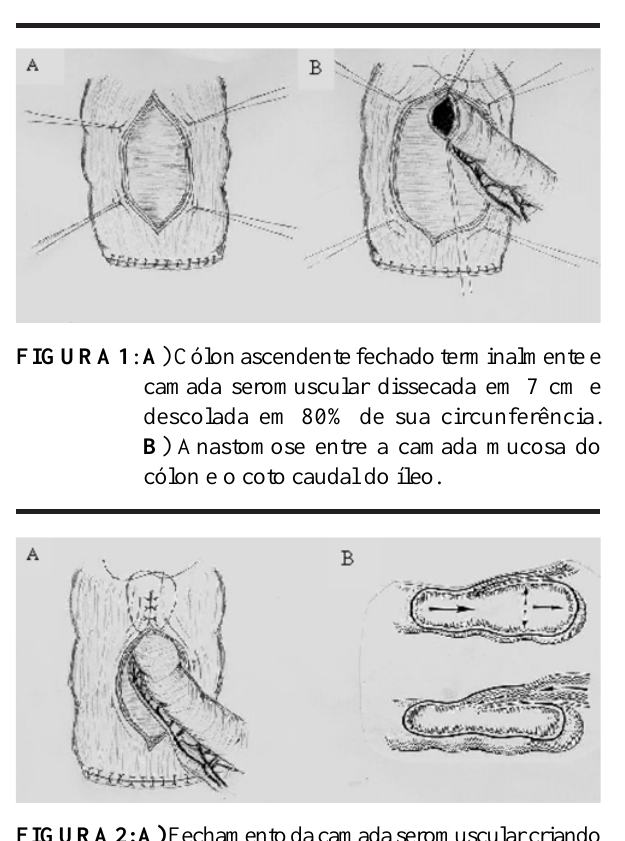
FIGURA 2: A) Fechamento da camada seromuscular criando um túnel submucoso. B ) Visão lateral das fases fisiológicas da neoválvula